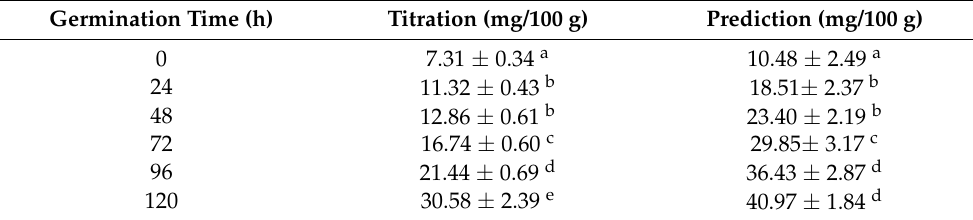
Table 3. Ascorbic acid value of bean sprout based on conventional and rapid methods.